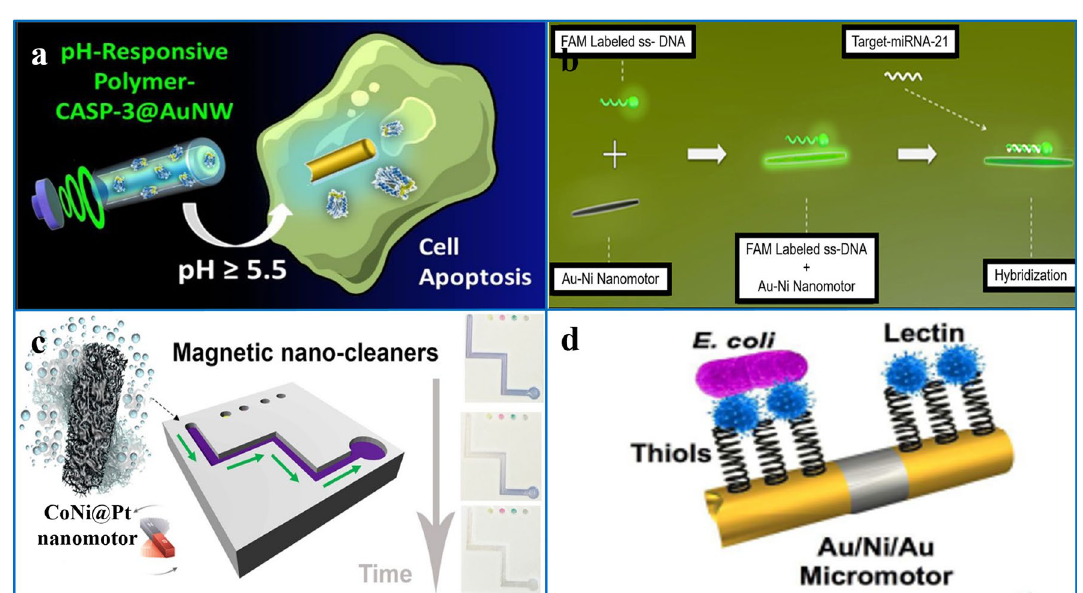
Fig. 9 Applications of 1D micro/nanomotors in different fields. a Au nanorod motor loaded with CASP-3 into cells and released into cells, leading to rapid cell apoptosis. Reprinted with permission from Ref. [39]. Copyright (2017) American Chemical Society. b Detection of cancer biomarker microRNA-21 with Au/Ni nanowires. Reprinted with permission from Ref. [125]. Copyright (2021) American Chemical Society. c Magnetic mesoporous CoNi@Pt nanorod degradation contaminants. Reprinted with permission from Ref. [171]. Copyright (2017) American Chemical Society. d E. coli captured by Au/Ni/Au micromotor modified concanavalin A. Reproduced with permission from Ref. [146]. Copy- right (2017) Royal Society of